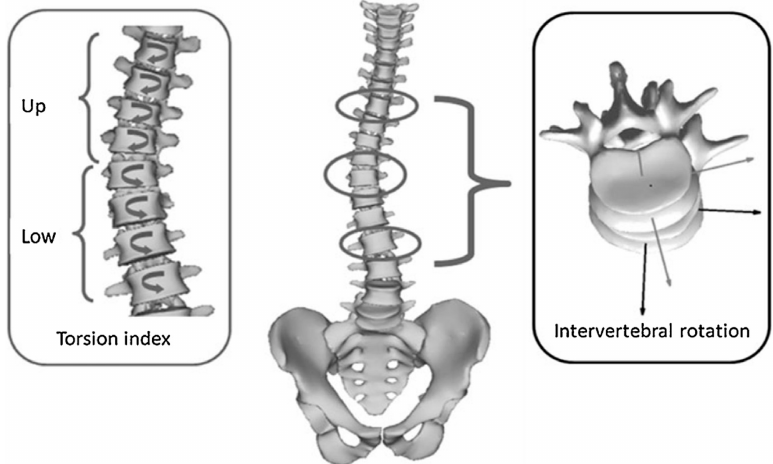
Figure 3. Transverse plane parameters including intervertebral rotation and torsion index.